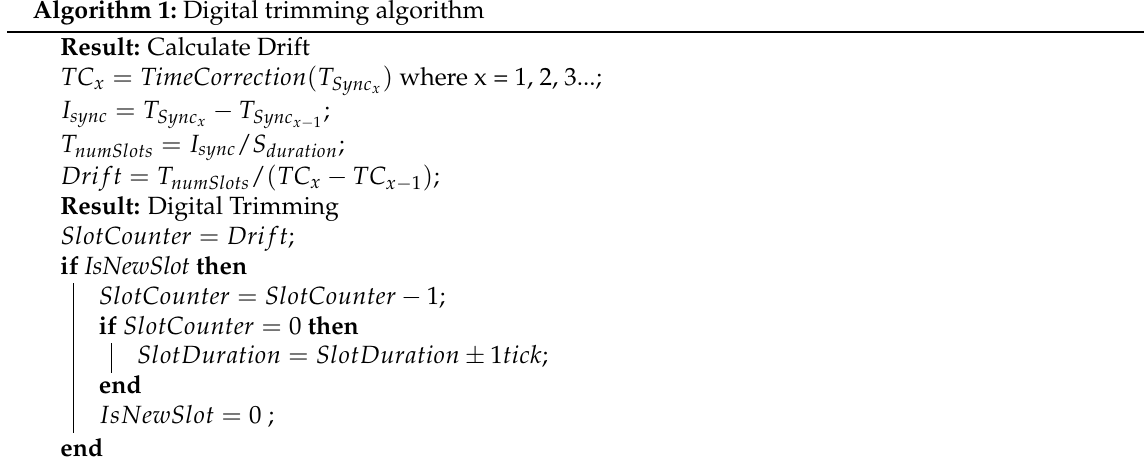
Algorithm 1: Digital trimming